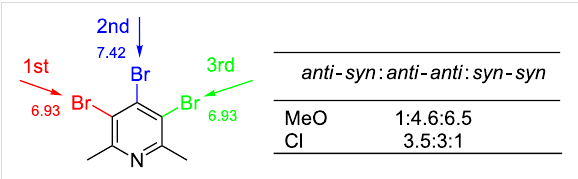
Figure 5: Summary of the results for coupling with ortho -substituted phenylboronic acid for triaryl